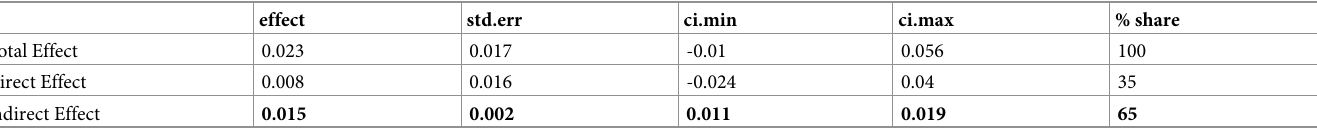
Table 4. Causal mediation